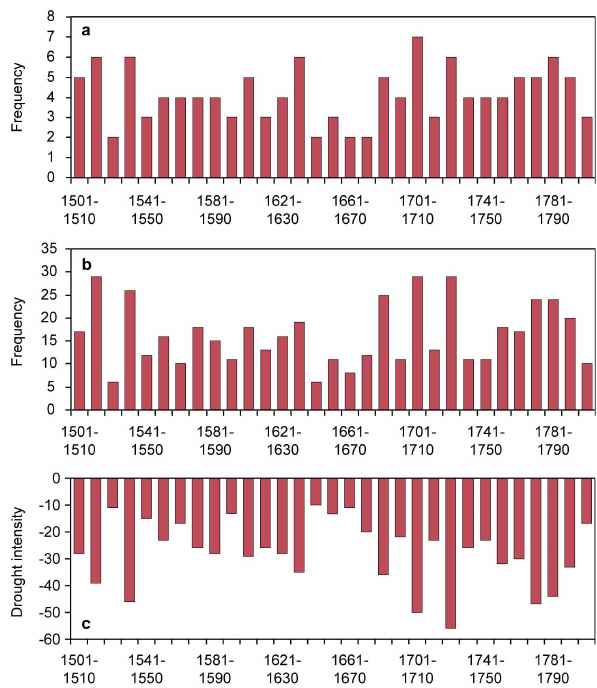
Fig. 4. Decadal frequencies of droughts in the Czech Lands in the 1501–1804 period: (a) years with drought, (b) dry months in drought years, (c) drought